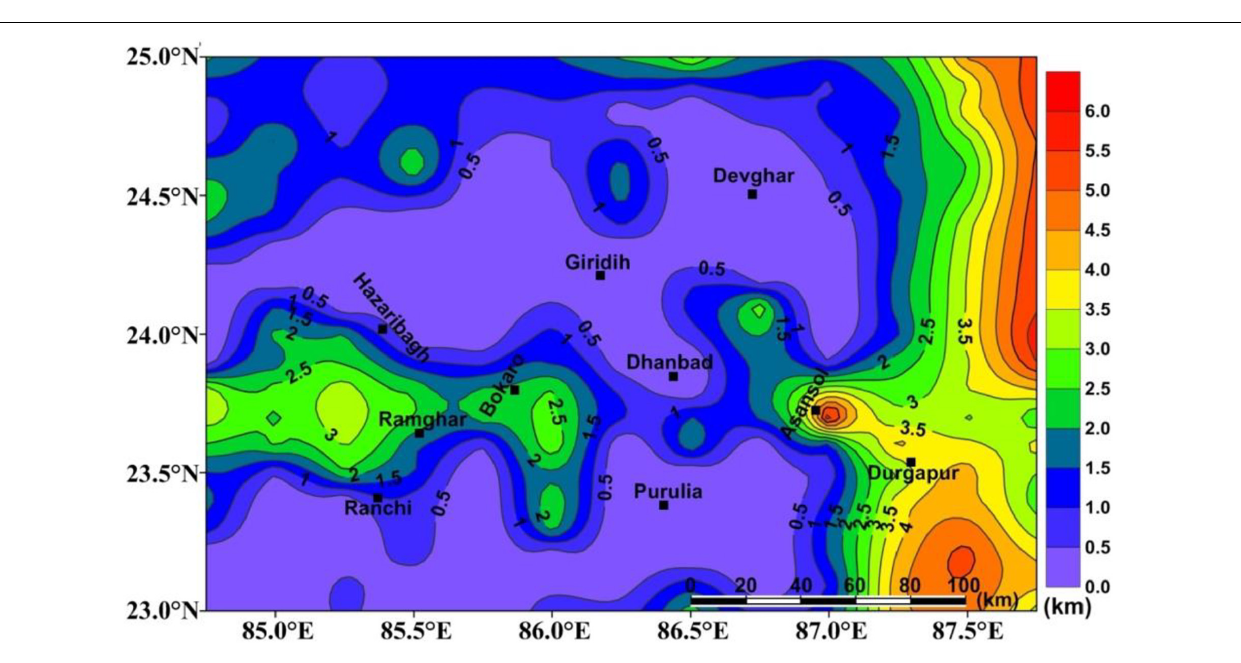
the Bokaro-Dhanbad coal field and the Purulia shear zone. The only difference is the upper crust exposed on the surface at each profile. Here, sediment thickness is 0–2.5 km and the Moho varies from ∼ 37 to 41 km. The observations corroborate